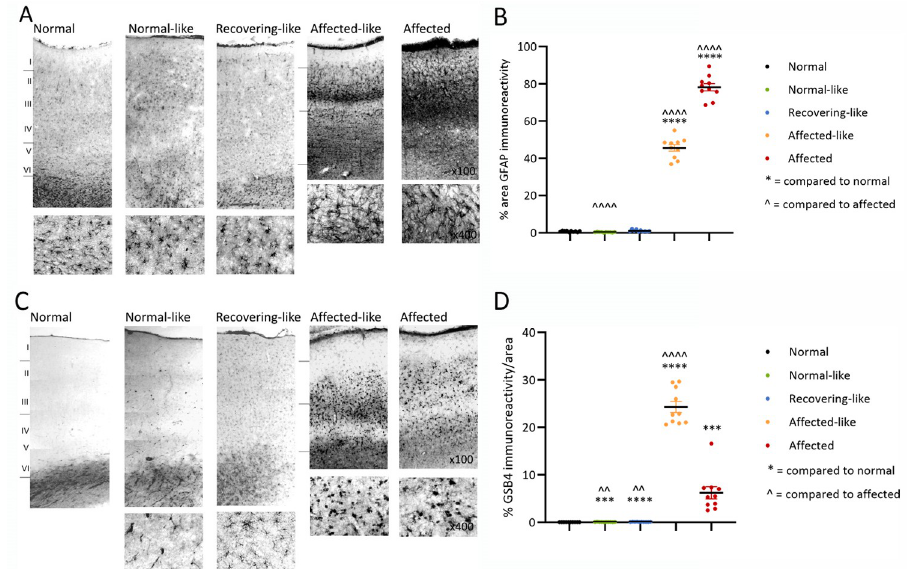
Fig 6. Glial activation in the occipital cortex. Representative images and quantification of astrocytic GFAP staining ( A, B ) and microglial GSB4 staining ( C, D of the occipital cortex). Affected-like chimeras display prominent astrocytic and microglial activation consistent with age-matched affected controls. One normal-like and one recovering-like chimera had scattered activated microglia and isolated brain macrophages throughout the cortical layers, whereas the remaining normal-like and recovering-like chimeras lack glial activation. See S2 Fig for all images. ˆˆ indicate P < 0.01, ��� indicates P < 0.001, ���� and ˆˆˆˆ indicate P <